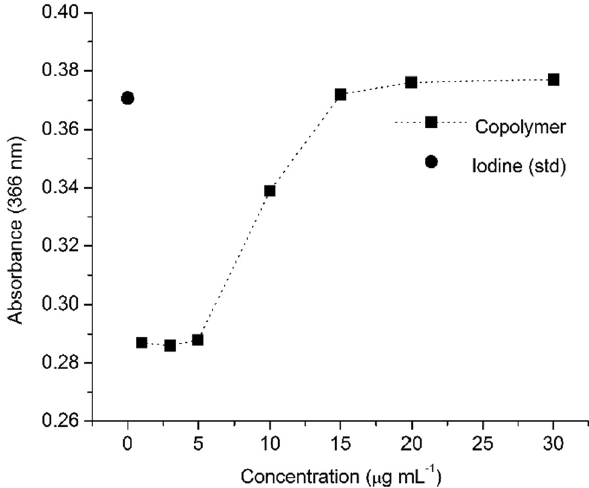
Figure 4: Absorbance values versus copolymer concentration mixed with Lugol ’ s reagent. CMC is determined at the concentration from which absorbance started to increase.